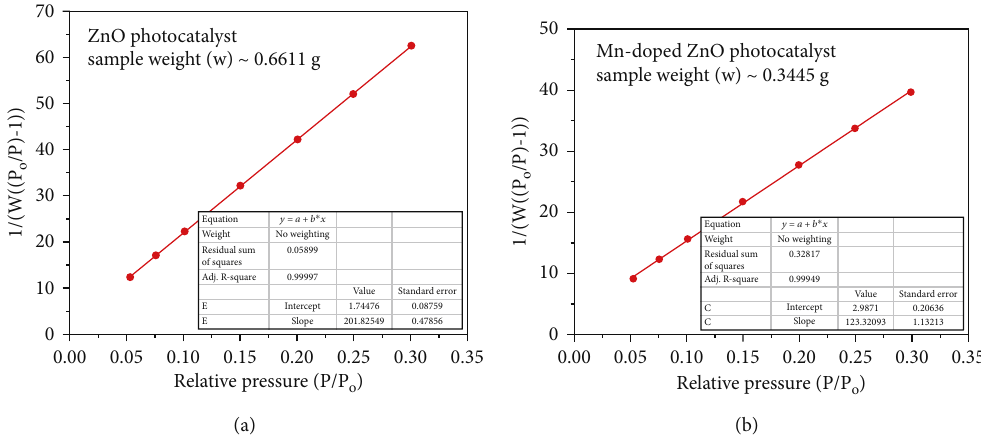
Figure 6: Linear plot of BET equation to determine the surface area of (a) pure ZnO and (b) Mn-doped ZnO